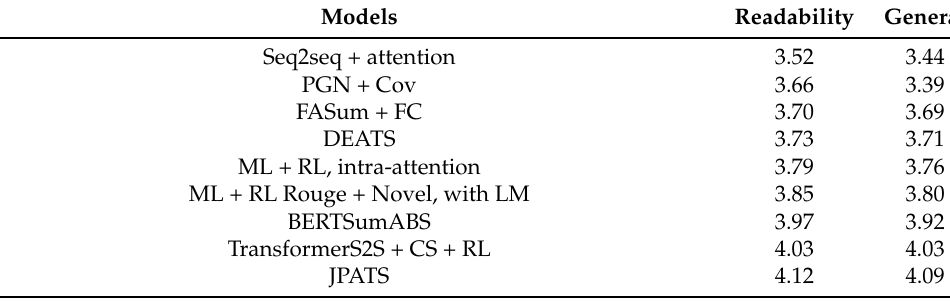
Table 2. Manual scoring of JPATS on the dataset